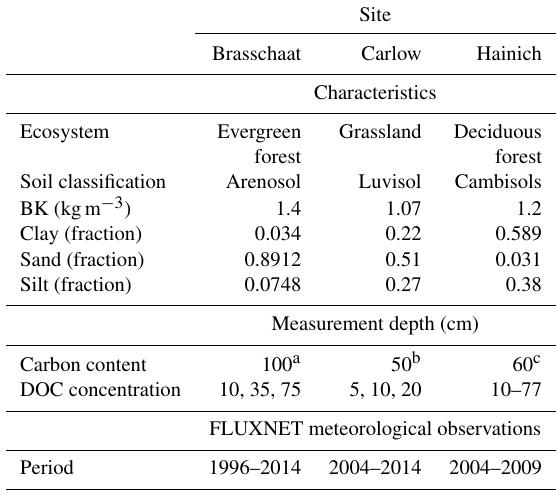
Table 4. Evaluation Level 1 site